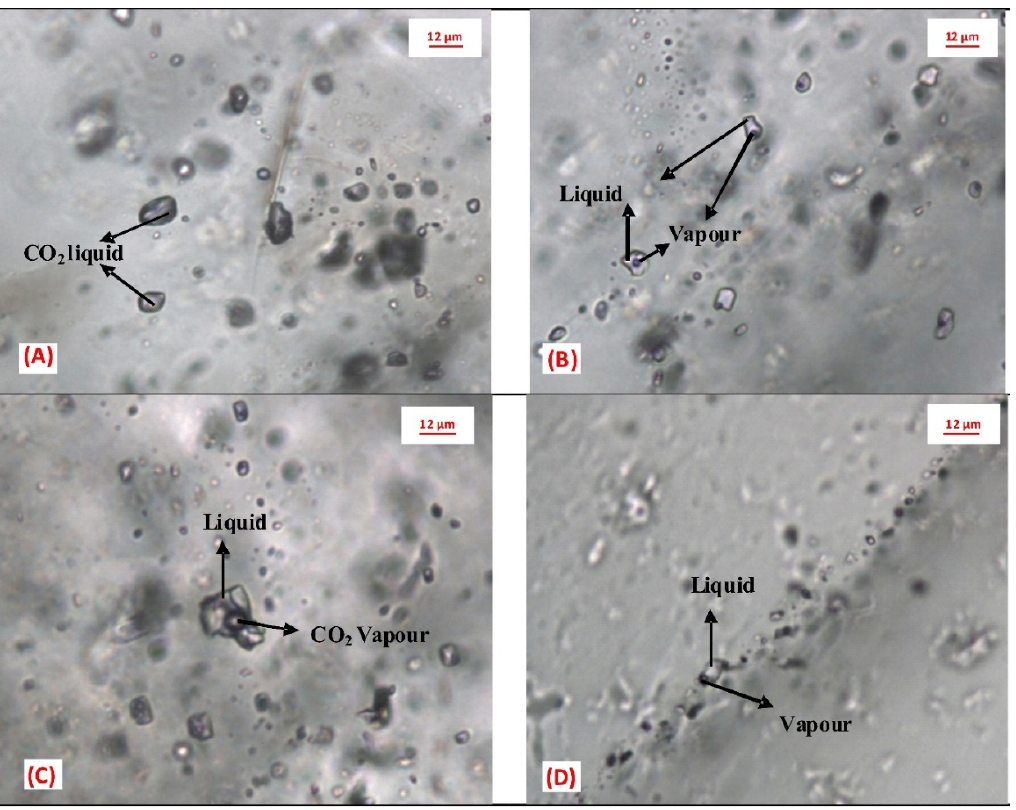
Figure 11. Types of fluid inclusions observed from study area. ( A ) Primary monophase carbonic (CO 2 ) inclusions; ( B ) Primary aqueous carbonic inclusions; ( C ) Primary aqueous bi-phase inclusions; ( D ) Secondary aqueous bi-phase inclusions. Table 4. Fluid inclusion results of different inclusions from the Jagpura